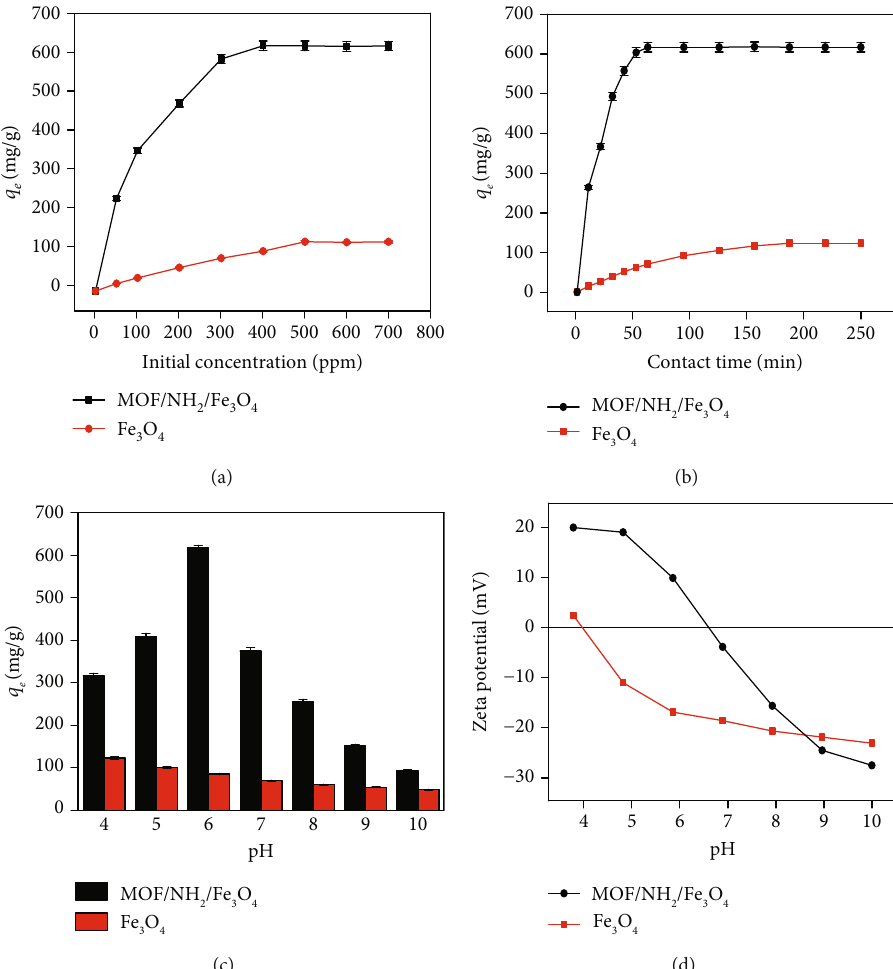
Figure 4: The e ff ect of initial dye concentration (a), e ff ect of contact time (b), e ff ect of pH (c), and Zeta potentials (d) for the adsorption of MO on the surface of Fe